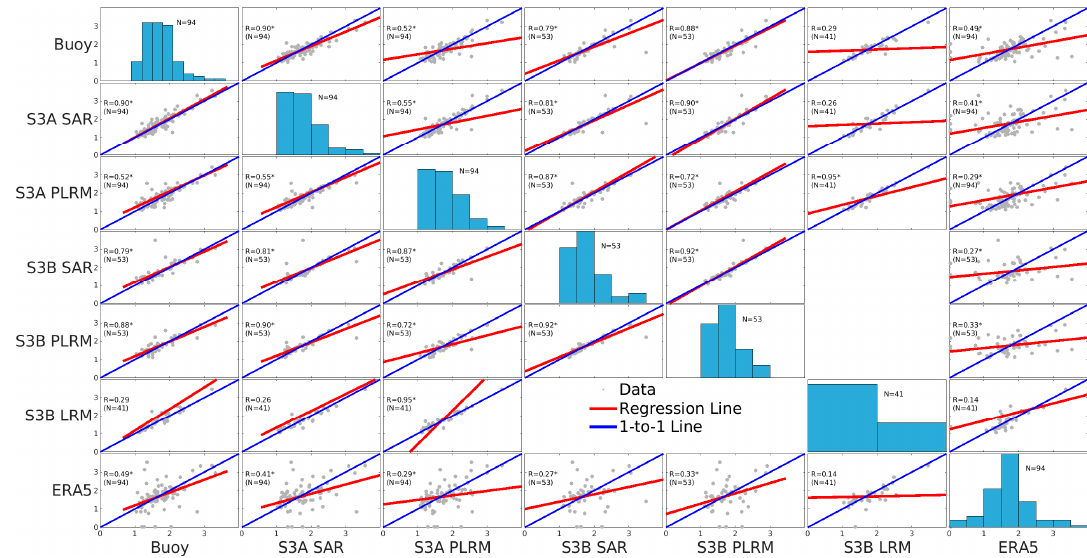
Figure 3. Buoy match-up results for significant wave height (SWH) Sentinel-3 and buoys. Labels identify variables plotted on the x-axis and y-axis. Histograms on diagonal relate to the variable identified on the x-axis. Scatterplots show data as grey dots, the least-square fit line in red, and the one-to-one line in blue. Each scatterplot includes the Pearson correlation coefficient (R; those that are significant at the 0.05 level are marked by *) and the number of data pairs (N).